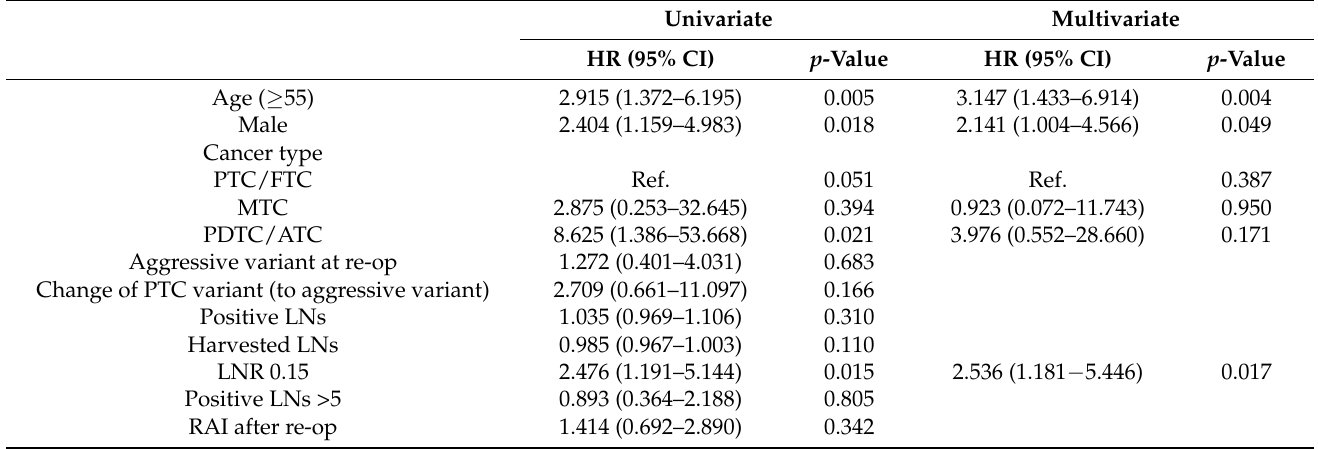
Table 5. Logistic regression analysis of risk factors for re-recurrence according to reoperation out- comes at the 1st recurrence.